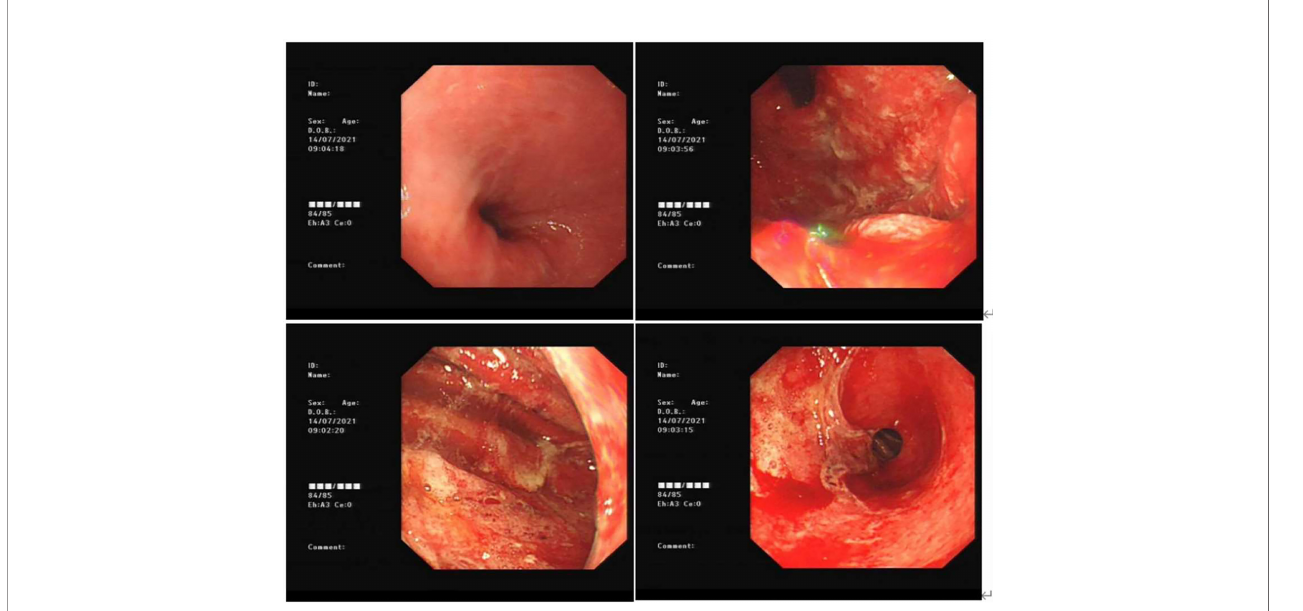
FIGURE 1 | Gastroscopy of acute erosive hemorrhagic gastritis for the fi rst time (day 502). The esophageal mucosa was smooth with good contraction; the whole gastric mucosa was evidently edematous and hyperemic with opaque mucous adhesions on the surface. Diffuse erosion of white moss was seen, and active oozing of blood was extensively observed. The gastric antrum was found to have a necrotic mucosa with exfoliation of large fl